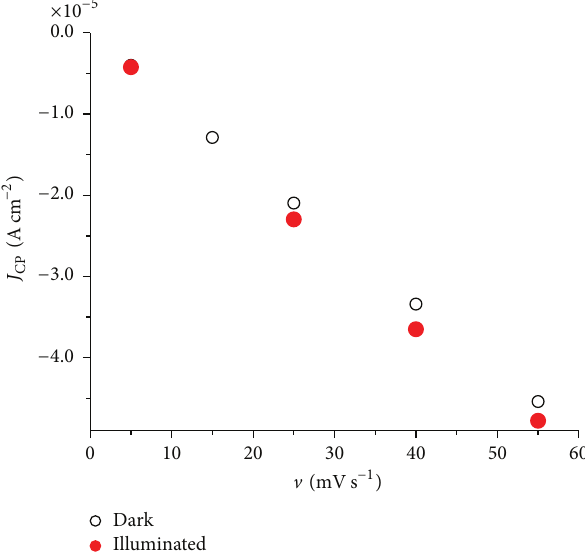
Figure 24: Scan rate ( V ) dependence of the cathodic current density ) present in the voltammograms of ERY-sensitized CS NiO peak ( 𝐽 CP coating deposited on ITO. Data have been extracted in the dark (from Figure 19) and under illumination (from Figure 20). The potential corresponding to the cathodic current density peak varies between 3.1 and 3.2 V versus Li + /Li, depending on the scan